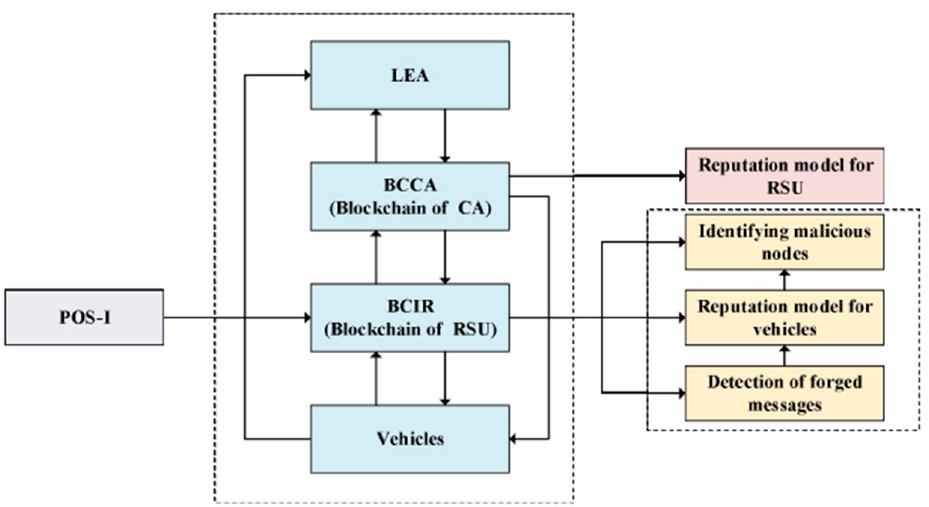
Figure 1. Schematic structure